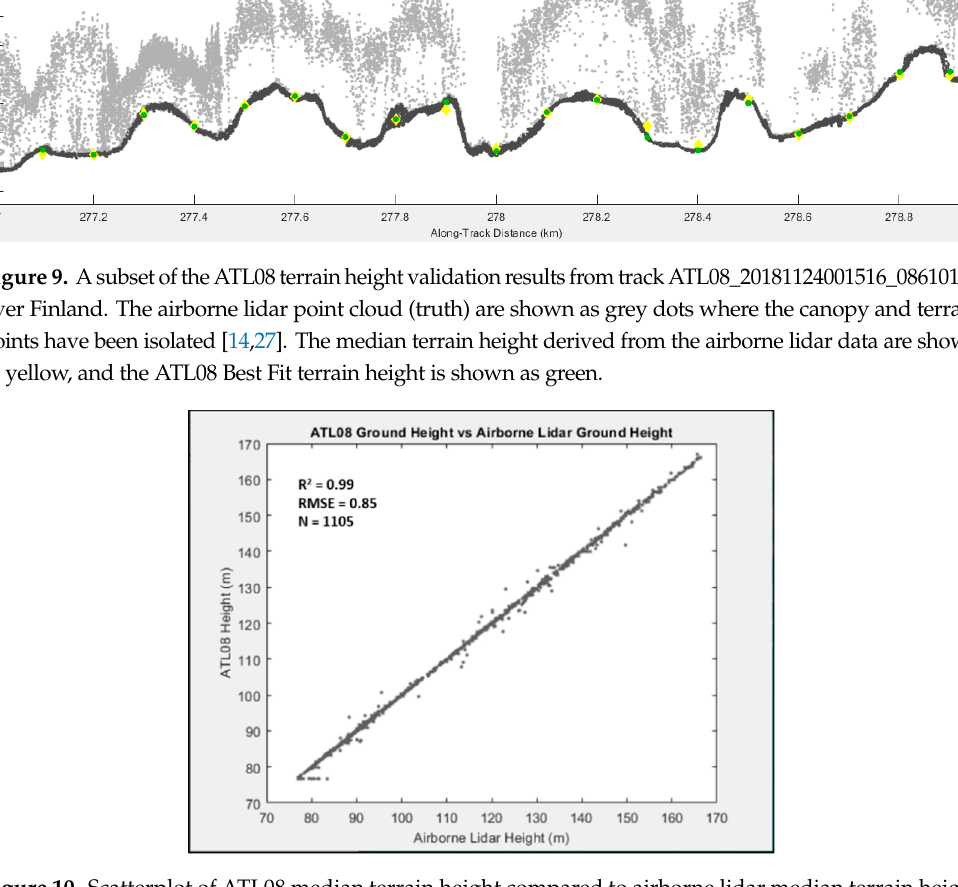
Figure 10. Scatterplot of ATL08 median terrain height compared to airborne lidar median terrain height within the 100 m segment for the full 200 km of analyzed data.